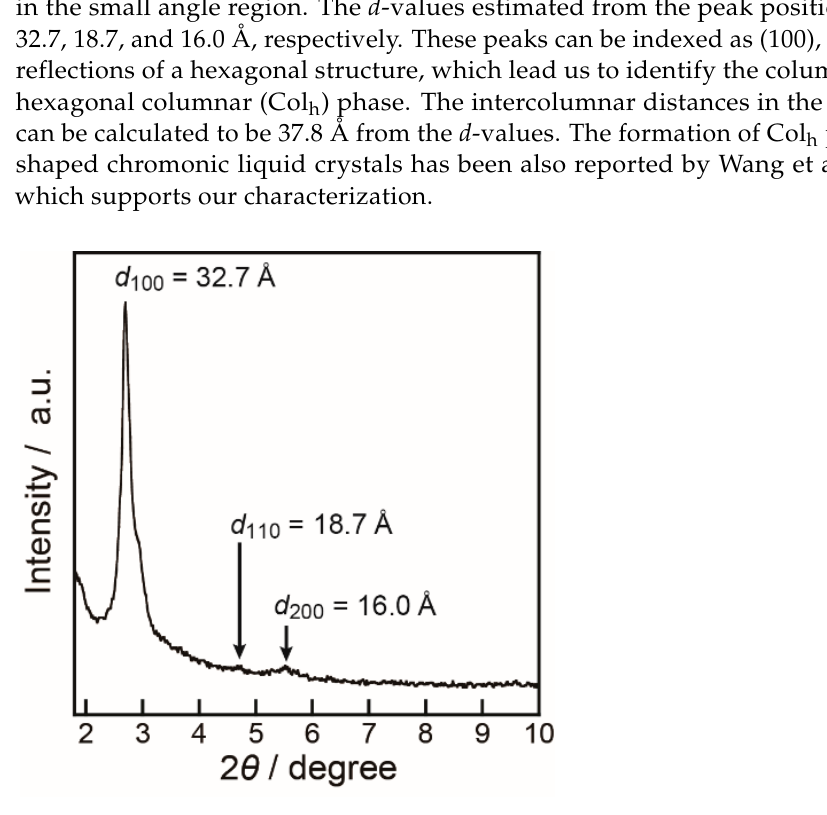
Figure 5. Polarized optical microscopic images of the mixtures of pQpdS-Ch /H 2 O (X = 60) in the Col h phase after shearing. ( a ) The shearing direction is parallel to the slow axis of the retardation plate. ( b ) The shearing direction is perpendicular to the slow axis of the retardation plate. In order to further confirm the molecular assembled structure of the pQpdS-Ch /H 2 O mixtures in the Col h phase, we have performed polarized IR measurements. A 1D-aligned